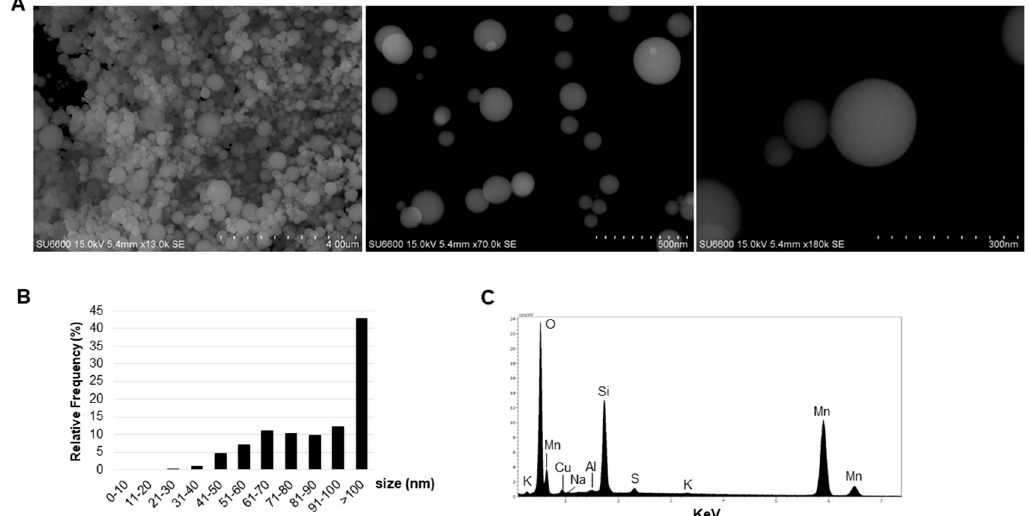
Figure 1. Characterization of dry SiMn dust by SEM. ( A ) Representative SEM images. ( B ) The diameter (nm) of the dust particles was measured and the relative frequency in percentage is shown for the different size groups with specific focus on particles ≤ 100 nm ( n = 252). ( C ) Energy-dispersive X-ray spectrum showing the elemental content of the dust particles.